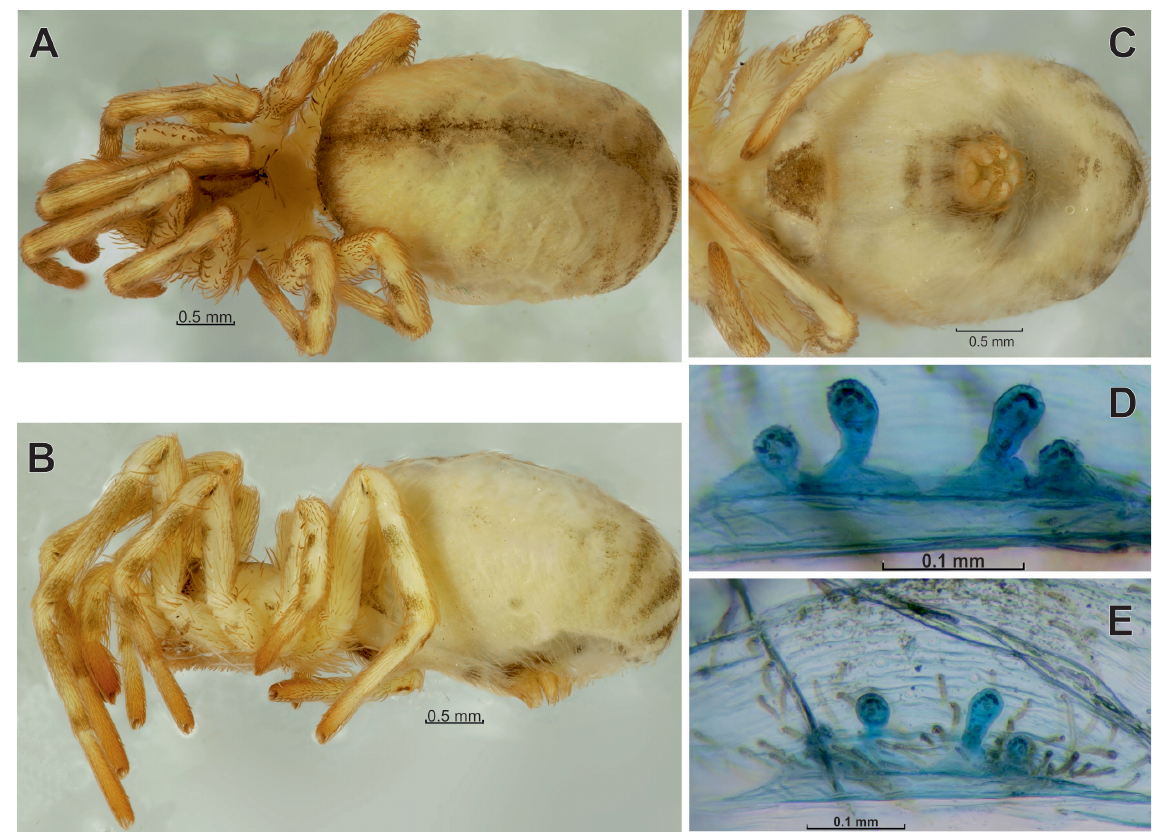
Fig. 36. Somatic characters and endogyne of Zaitunia feti sp. nov., holotype, ♀. A – B . Habitus, dorso- lateral and lateral. C . abdomen, ventral. D–E . endogyne,